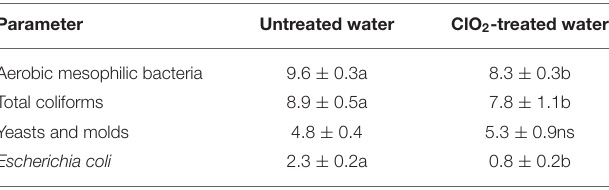
TABLE 2 | Microbiological populations in recirculated wash waters (log cfu/100mL; mean ± standard deviation; n = 10).